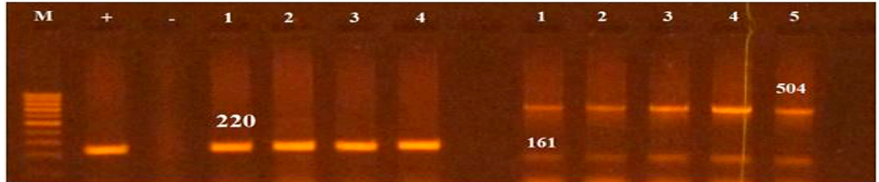
Figure 3. PCR based screening of sopB (220), tolC (161bp) and spaN (504bp). Lane M represents 100bp ladder.